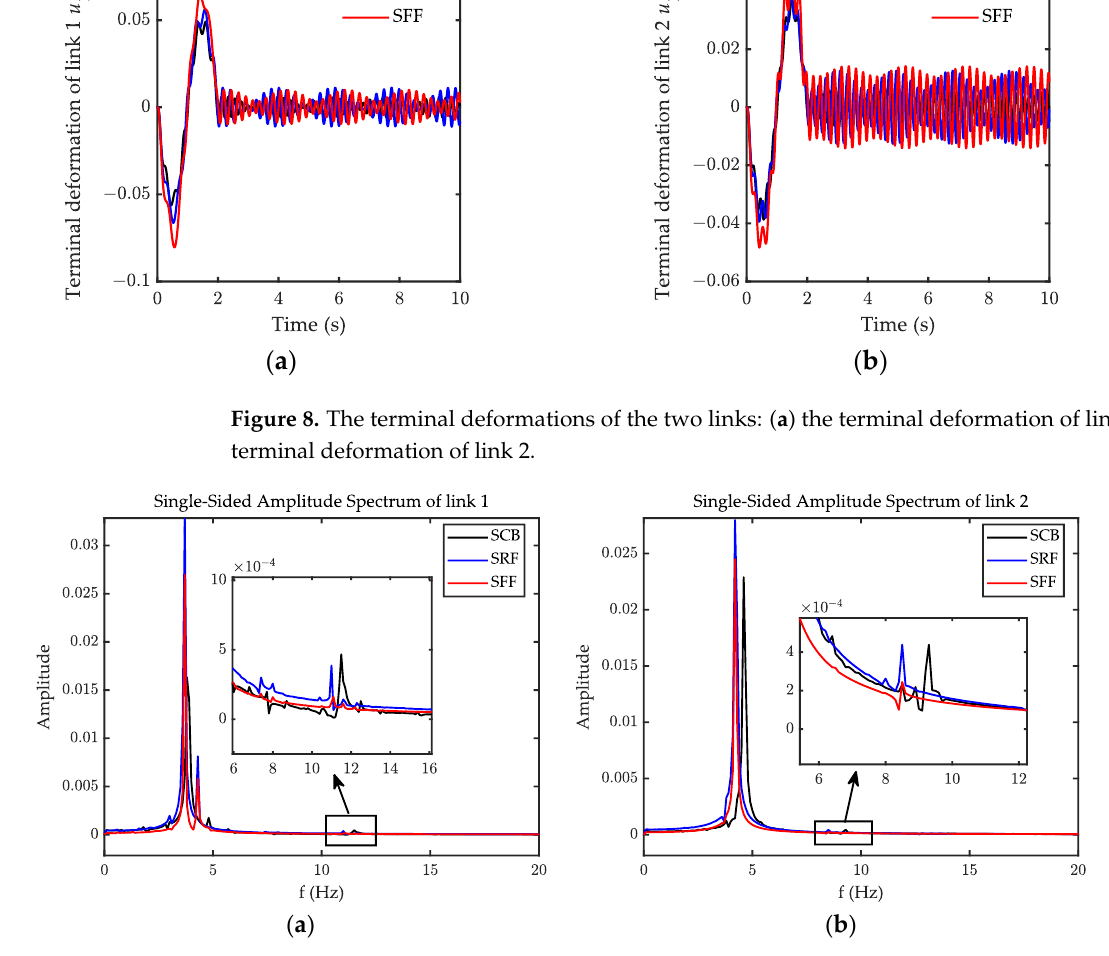
Figure 9. The single-sided amplitude spectrum: ( a ) the single-sided amplitude spectrum of link1; ( b ) the single-sided amplitude spectrum of link2.